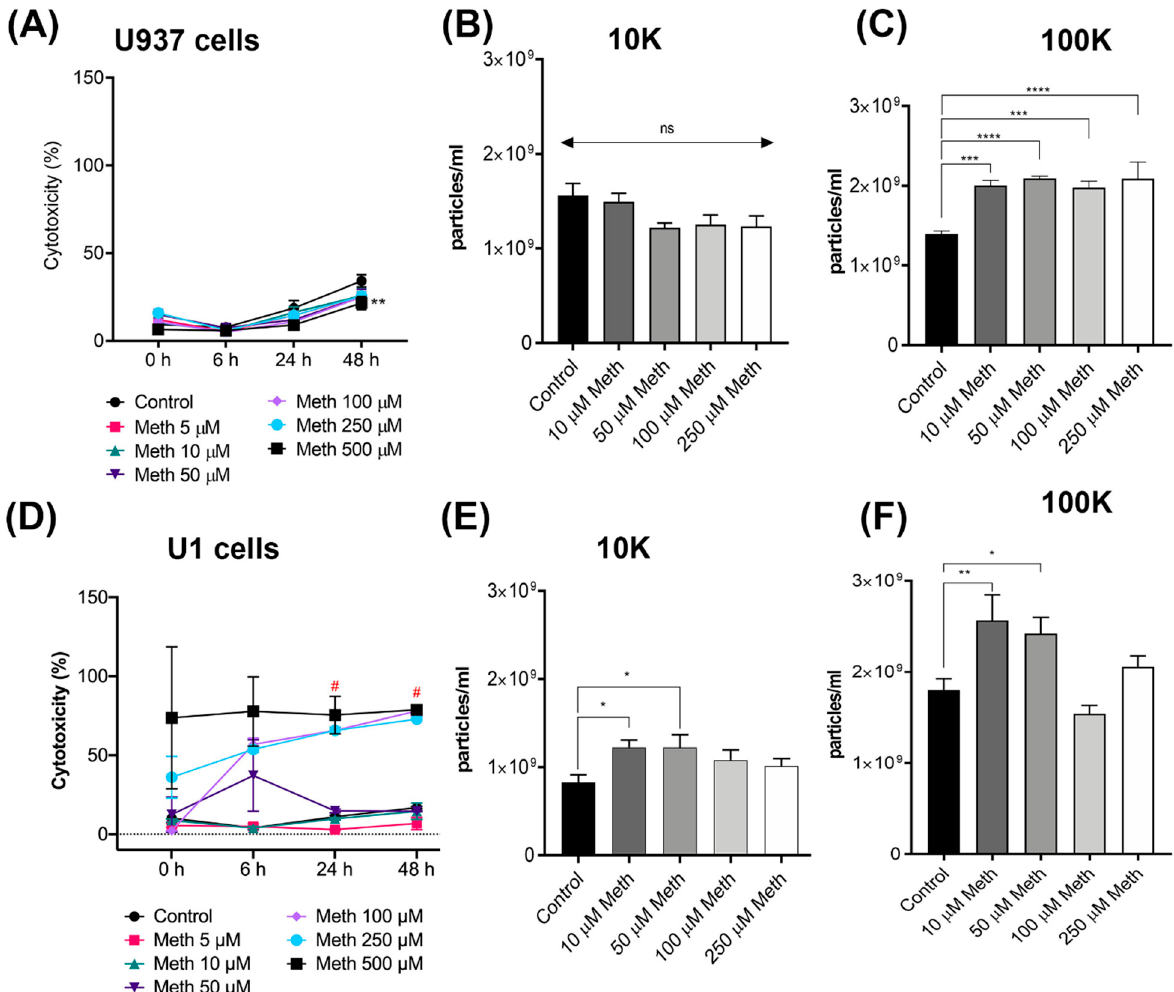
Figure 1. Impact of meth on cell toxicity and EV biogenesis. Cytotoxicity assay in U937 cells ( A ) treated with 0, 5, 10, 50, 100, 250, and 500 µM meth for 48 h ( n = 3). NTA measurements for EVs concentration of 10 K-EV ( B ) and 100 K-EV ( C ). Cytotoxicity assay in U1 cells ( D ) treated with different concentrations of meth for 48 h ( n = 3). NTA concentration measurements of U1-10 K-EV ( E ) and 100 K-EV ( F ). Data are shown as mean +/ − SEM and represent at least three independent assays done in triplicate. * p < 0.05; ** p < 0.01; *** p < 0.001, **** p < 0.0001, and ns = not significant. U937: human monocyte; U1: chronically infected HIV-1 promonocytic; 10 K: 10,000 × g ; 100 K: 100,000 × g